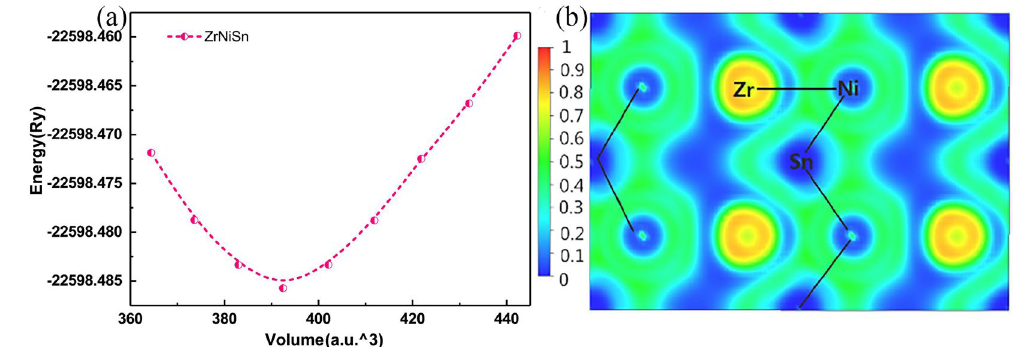
Figure 2. ( a ) The fitted E-V curve of ZrNiSn structure. ( b ) Calculated ELF in the (0 0 1) plane of